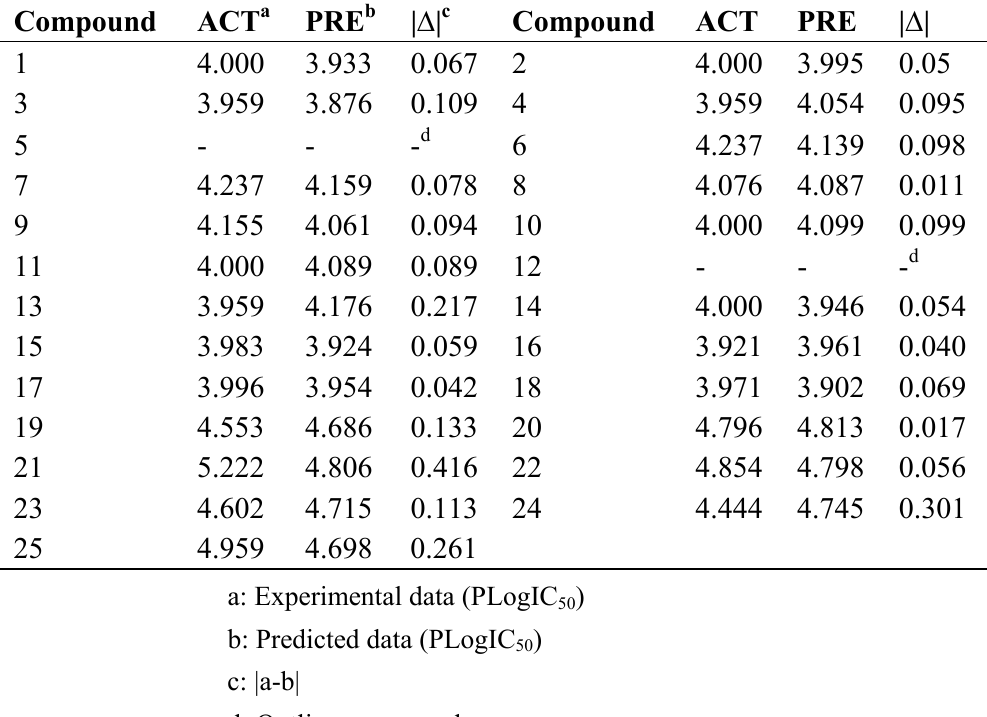
Table 1. Comparison of the predicted PLogIC50 of database with the experimental values by using 2D-QSAR Model.